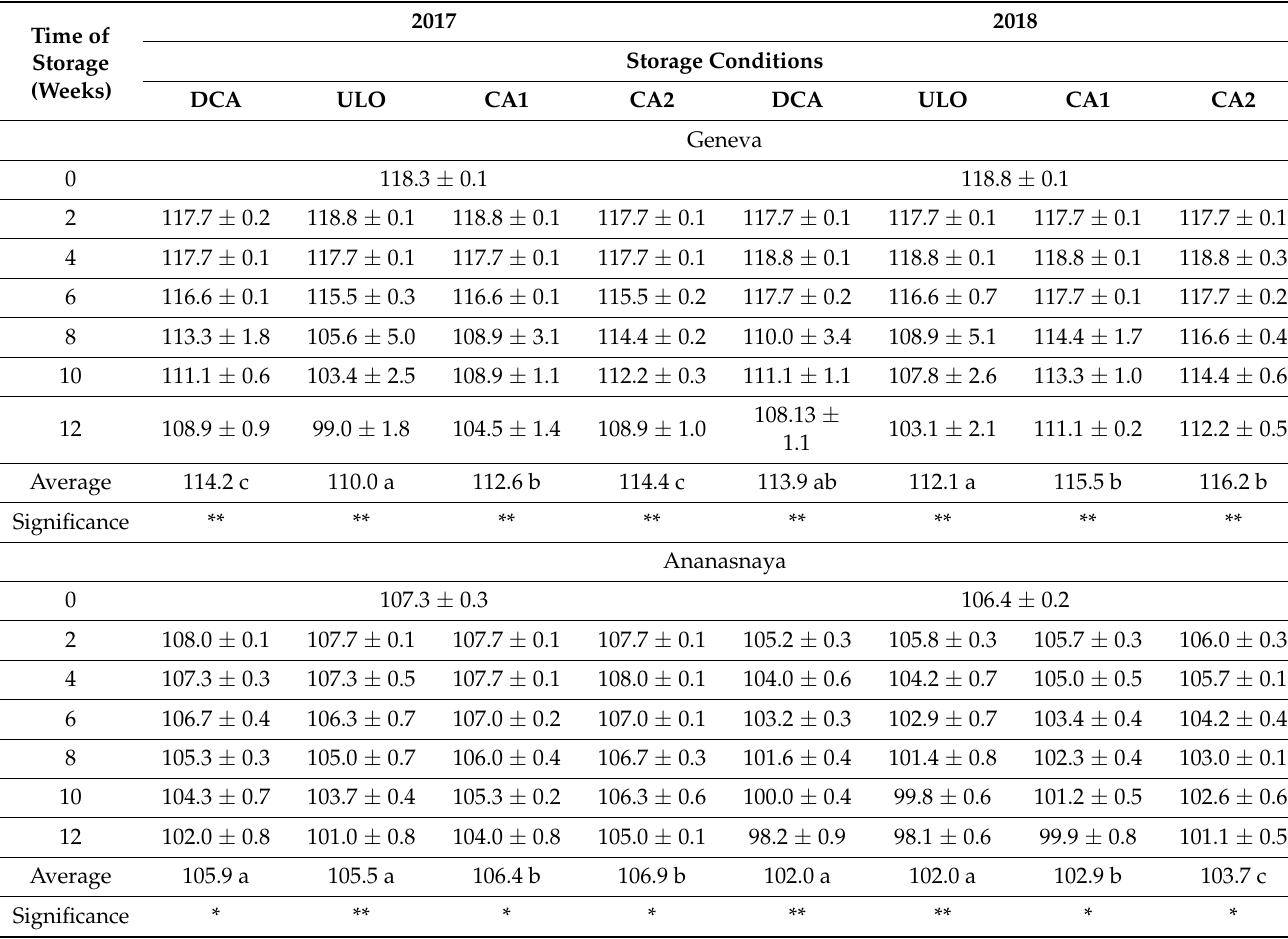
Table 12. Changes in skin color (Hue Angle) measured in ‘Geneva’ and ‘Ananasnaya’ minikiwi fruits in the postharvest period. Time